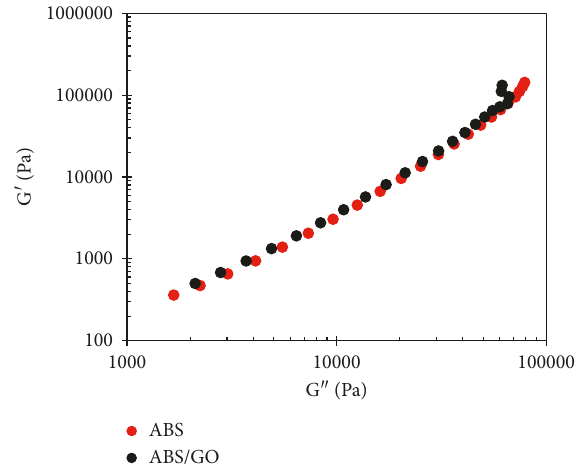
Figure 11: G versus G plot for (red) ABS filament and (black) ABS/GO composite ′ ″